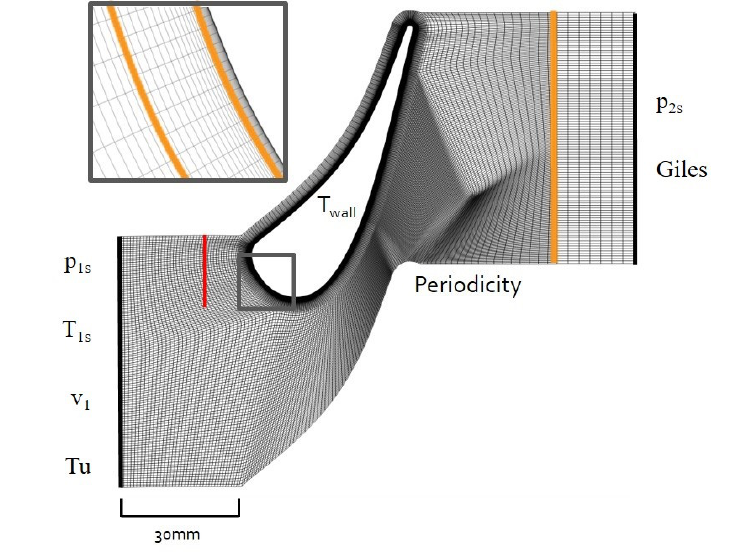
Figure 1. Computational grid and